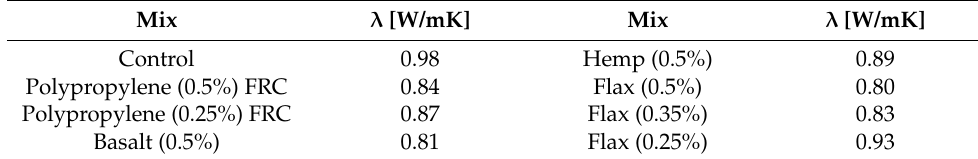
Table 11. Thermal conductivity ( λ